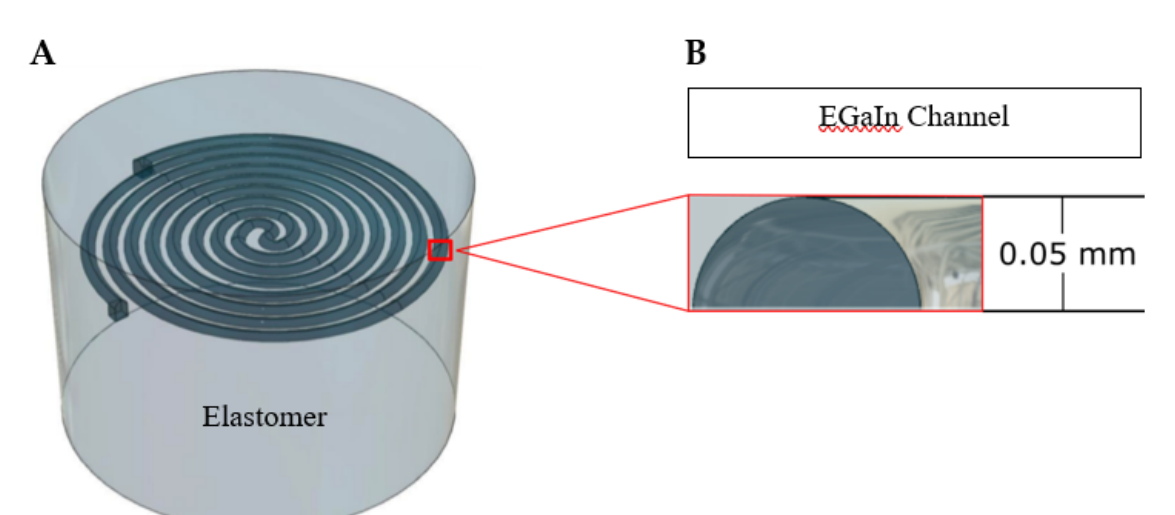
Figure 2. ( A ) A 3D rendered image of the soft microsensor design based on the novel fabrication method created by Parekh et al. [19] and spiral design featured in [15]. The sensor exhibits a semicircular channel cross section due to the resulting geometry of 3D printing liquid metal onto cured elastomer. ( B ) The semicircular channel is embedded 0.5 mm beneath the surface of the elastomeric shell of the sensor. The channel forms a spiral structure to maximize the length and resolution of the sensor.